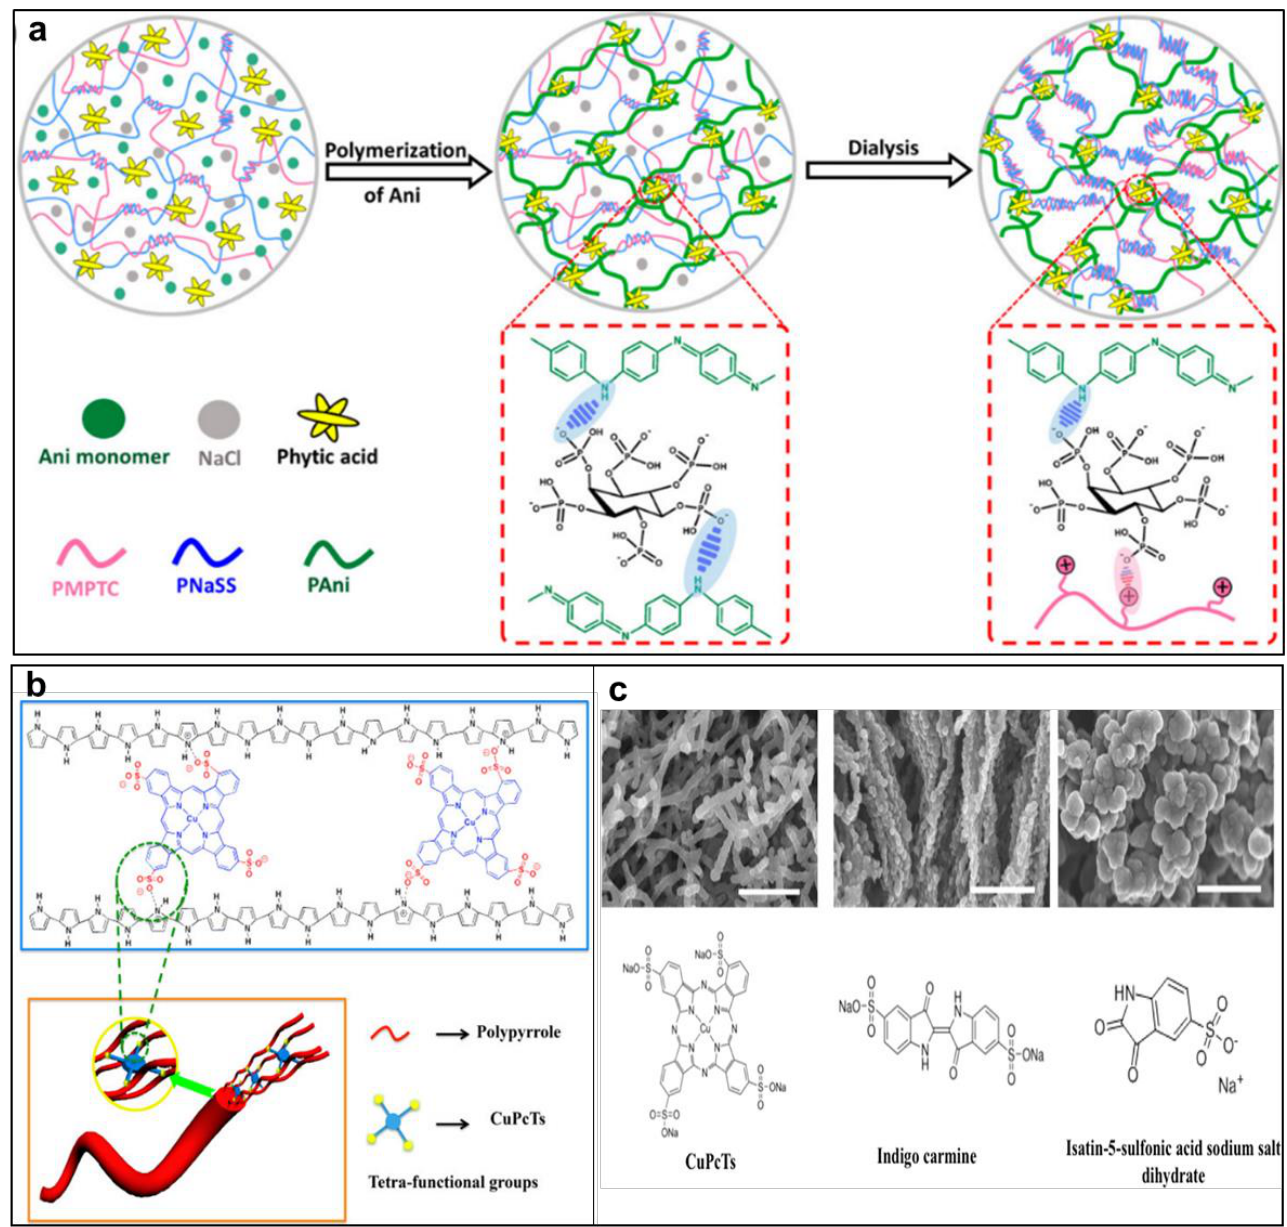
Figure 4. ( a ) The preparation process of the PIC/PANI composite hydrogel by blending of PANI, phytic acid, and NaCl (reprinted with permission from ref. [57]); ( b ) synthesis of nanostructured PPy CPHs using a doping method; and ( c ) SEM images of various nanostructured PPy hydrogels with different doping agents (reprinted with permission from ref. [61]).